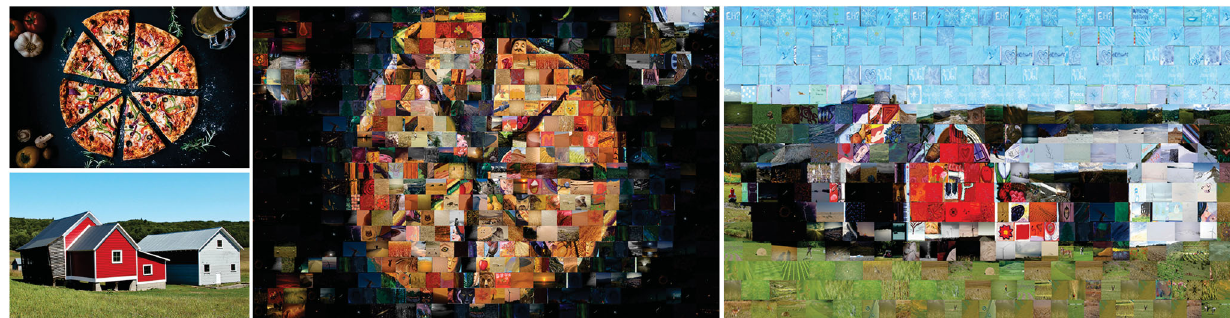
Fig. 1 Discernible image mosaics generated by our method (center, right). The replacement photographs in the mosaic tiles remain recognizable while together they resemble the target photographs (left). Two unique features of our method are the use of adaptive mosaic tiles, whose sizes vary, and edge preservation , e.g., see outlines of the